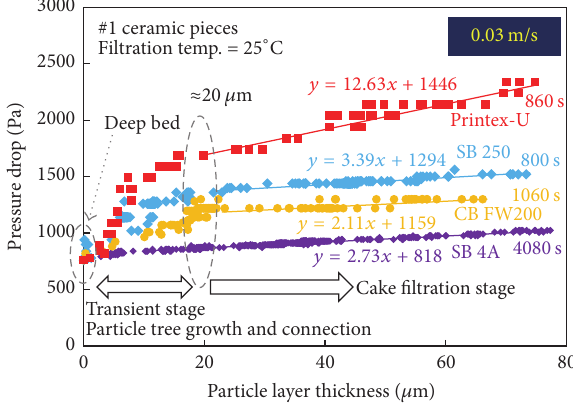
Figure 13: The pressure drop of different carbon black